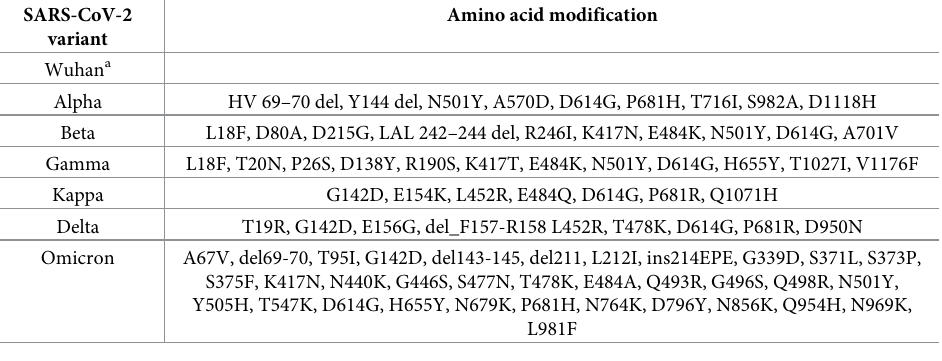
Table 1. VoCs used in this